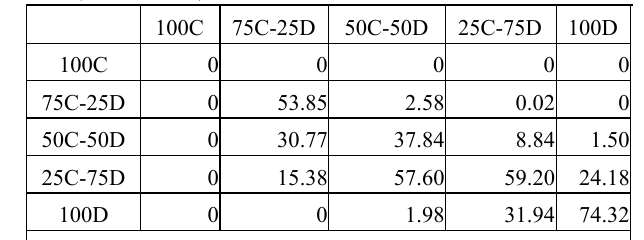
Overall classification accuracy: 60.74% Overall classification accuracy: 68.12%